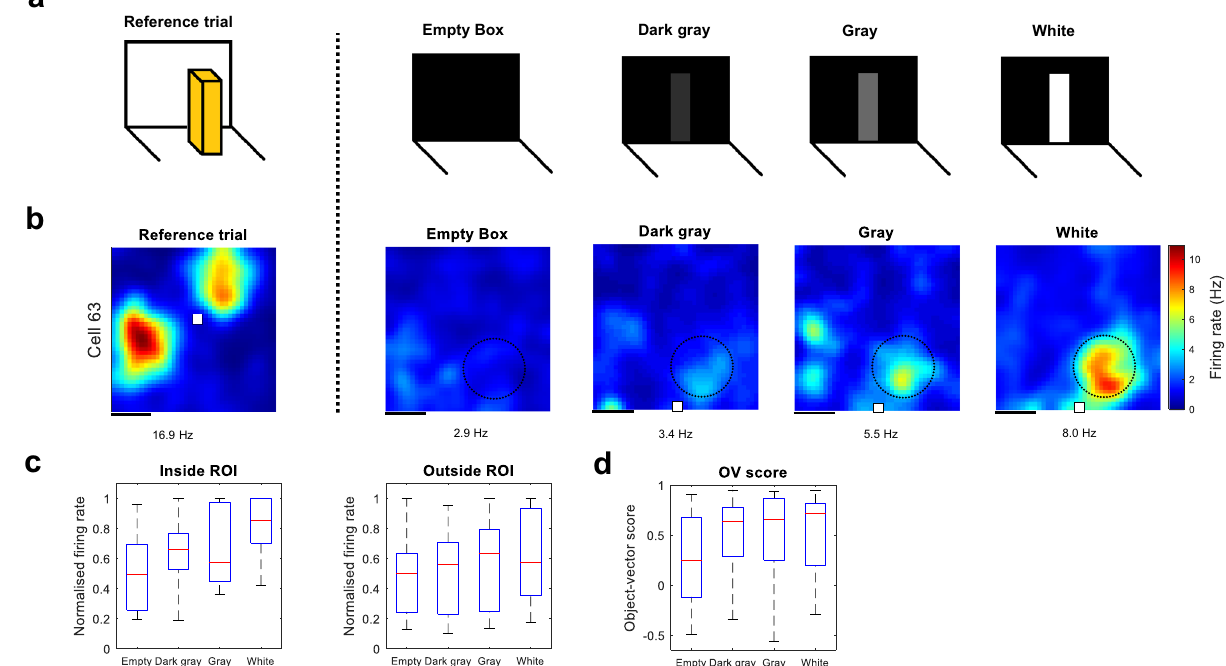
Fig. 4 Responses of object-vector cells to visual contrasts. a Experimental design with four different trials: either the box was empty or had a visual contrast present. In the three trials with a visual contrast, we varied the object ’ s contrast from dark grey, to grey, to white (10%, 60% and 100% whiteness, respectively). The reference trial, used to fi nd the cell ’ s vector coordinates, is shown on the left. b Example rate maps from OV cell clearly increasing its fi ring rate as a function of visual contrast. Rate map conventions are as in Fig. 2. Scale bar, 20 cm. c Box-and-whisker plots of normalised fi ring rates (Hz) of OV cells ( n = 14) as a function of the object ’ s visual contrast. The fi ring rate was measured either inside (left) or outside the ROI (right). d Box-and-whisker plot of OV scores as a function of visual contrast. Conventions for box-and-whisker plots are as in Fig.